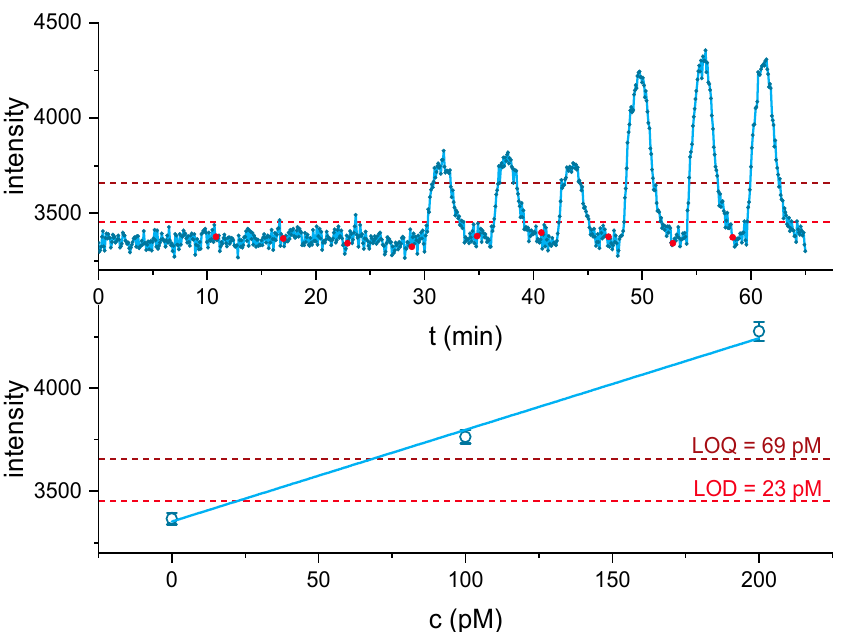
Figure 8. Injection of 0, 100, and 200 pM cocaine ( top ) with highlighted injection start (red dots). The obtained intensities were evaluated ( bottom ) and linearly fitted. The limit of detection and quantification were determined as 3 s of the baseline with three blank injections and were highlighted in both graphics. The limit of detection (LOD) was determined to be 23 pM (7 ppt), a total amount of 4 pg cocaine. The reaction time, before a sample of 100 pM cocaine was sufficient to exceed background, was determined to be approx. 1.6 min and peak maximum was reached after approx. 3 min.